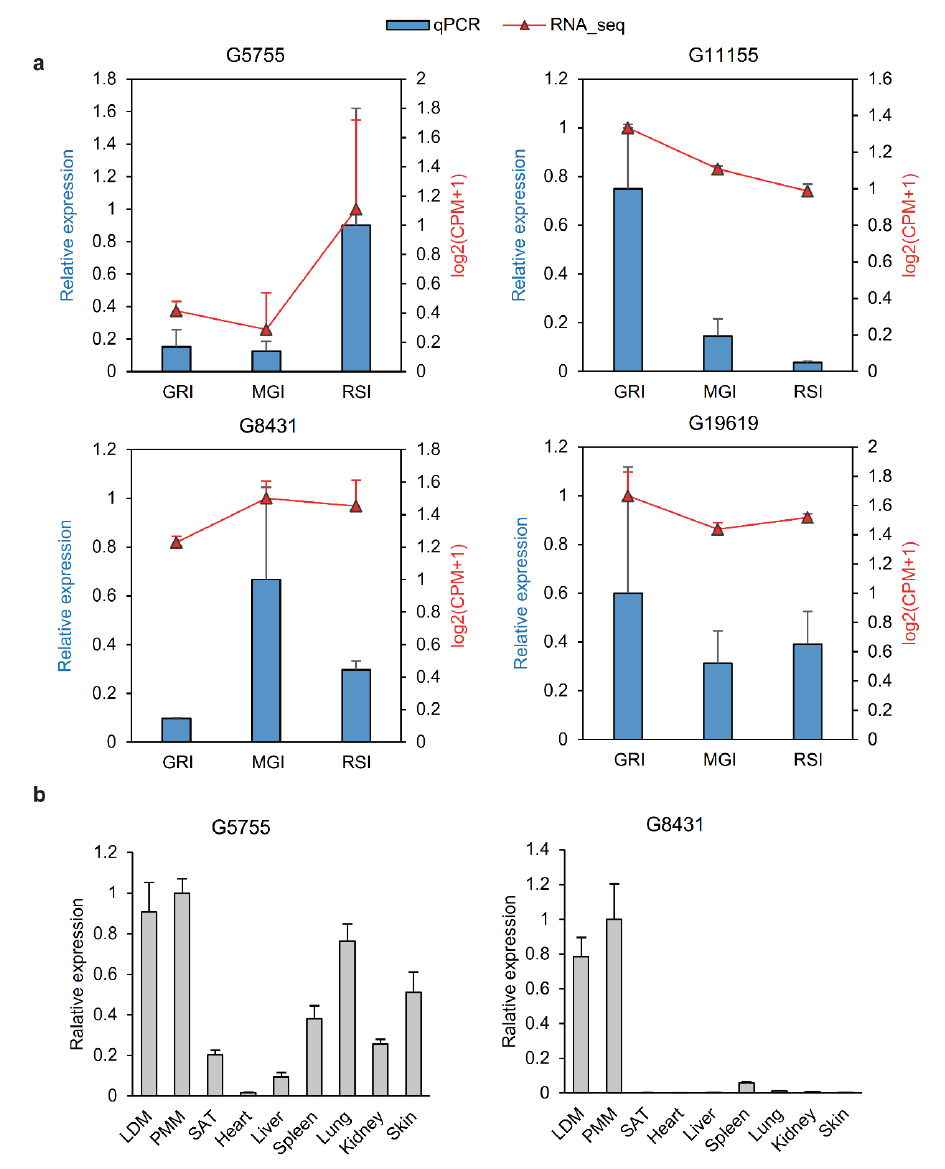
Figure 6. qRT-PCR validation of lncRNAs during muscle development. ( a ) Validation of four lncRNAs by qRT-PCR. The x-axis represents the three developmental stages of muscle. The y-axis indicates the relative expression of each lncRNA; red lines are log2(CPM+1) values of RNA-seq and the blue lines show relative expression by qRT-PCR. ( b ) Tissue expression of two lncRNAs ( G5755 and G8431 ). Data are shown as means ± SD. Data are representative of at least three independent experiments. MGI, the inflection point with the maximum growth rate; GRI, the inflection of the gradually increasing stage to the rapidly increasing stage; RSI, the inflection point of the rapidly increasing stage to the slowly increasing